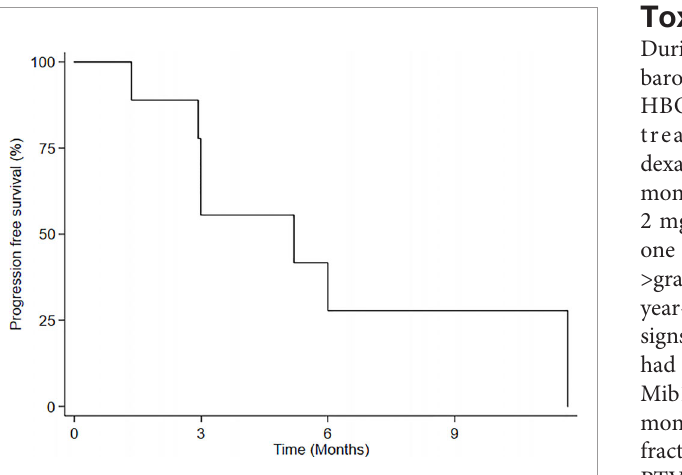
FIGURE 2 | Progression-free survival (PFS) after HBO-RT.